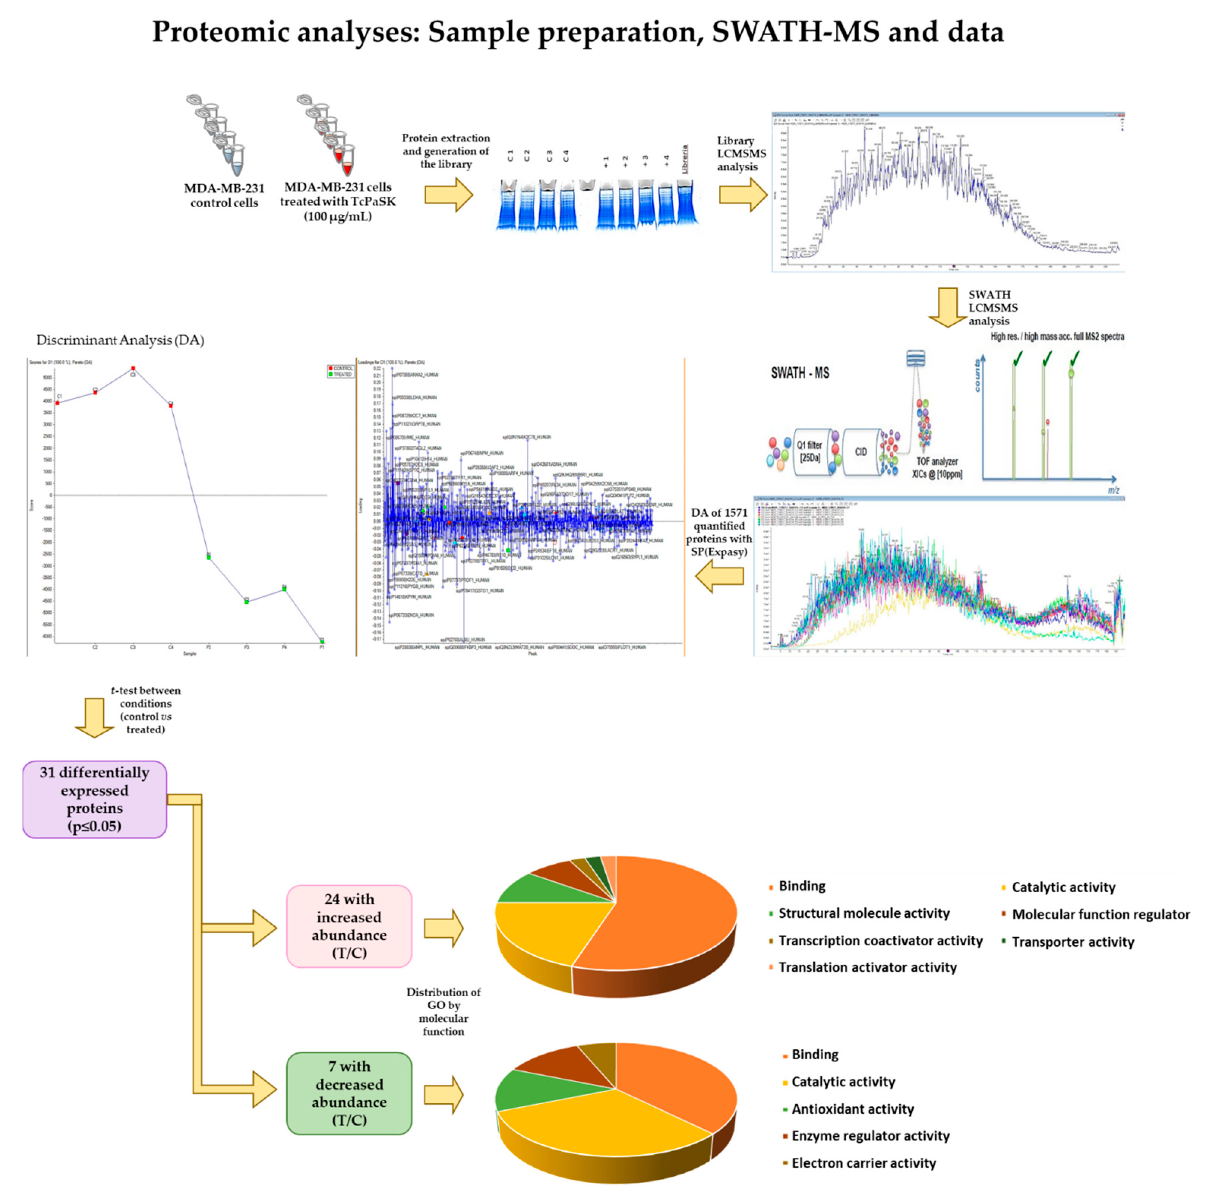
Figure 7. Quantitative SWATH proteomic analysis. The workflow indicates the steps followed in the SWATH analysis performed on four biological replicates of non-treated MDA-MB-231 cells treated and four biological replicates of MDA-MB-231 cells treated with 100 µ g/mL TcPaSK peptide. Out of the 1571 proteins identified by means of bioinformatics analysis, 31 were differentially expressed in treated samples as compared to non-treated samples ( t -test, p ≤ 0.5). GO molecular function categories of increased and decreased abundance proteins (Treatment vs. Control) are shown. Table 2. Differentially expressed proteins identified by SWATHS analysis in MDA-MB-231 TNBC cells treated (T) or not (C) with TcPaSK peptide. Shown in bold are proteins exhibiting ≥ 1.5-fold change T/C.